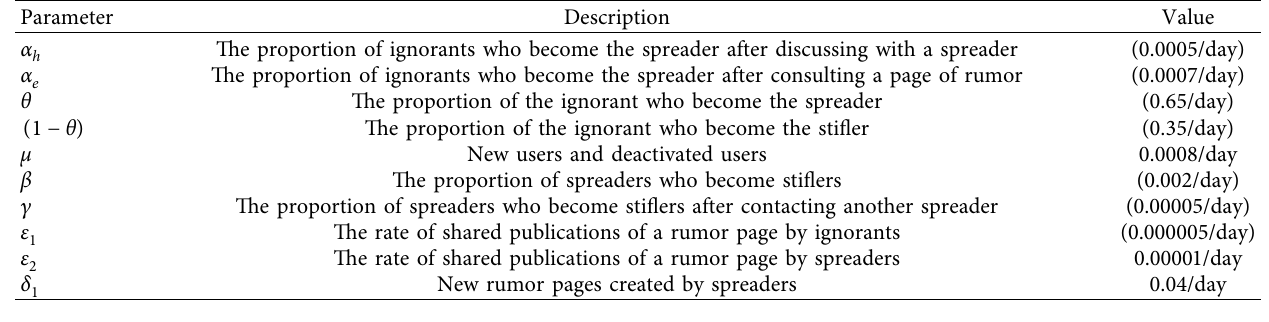
Table 1: Rumor model parameters and values.